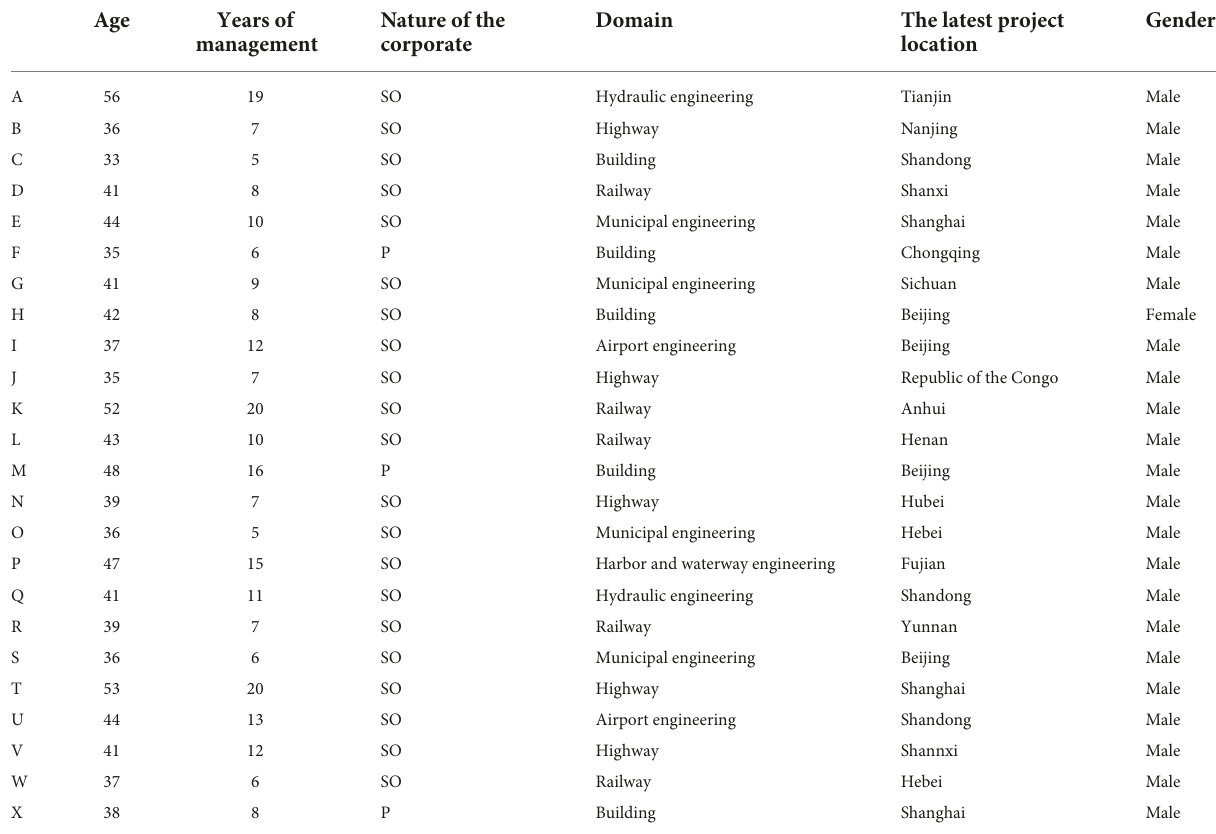
TABLE 1 Information of participants included in the interview